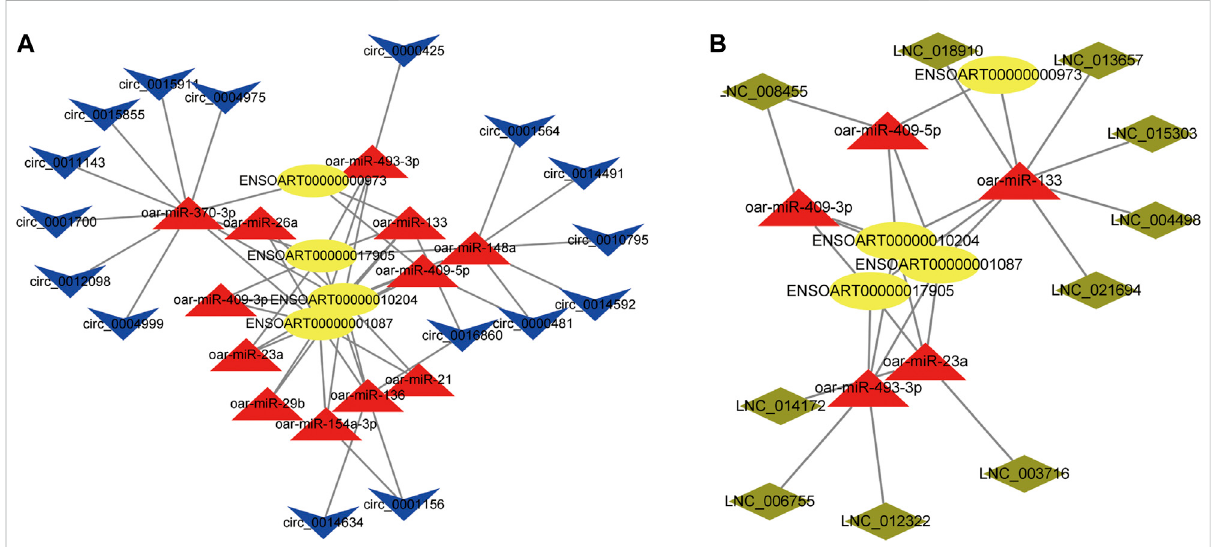
FIGURE 7 (A) CircRNA-miRNA-mRNA interaction network speci fi cally expressed in Tan sheep. (B) LncRNA-miRNA-mRNA interaction network speci fi cally expressed in Tan sheep. The ovals, triangles, parallelograms and V types represent mRNAs, miRNAs, IncRNAs and circRNAs, respectively.